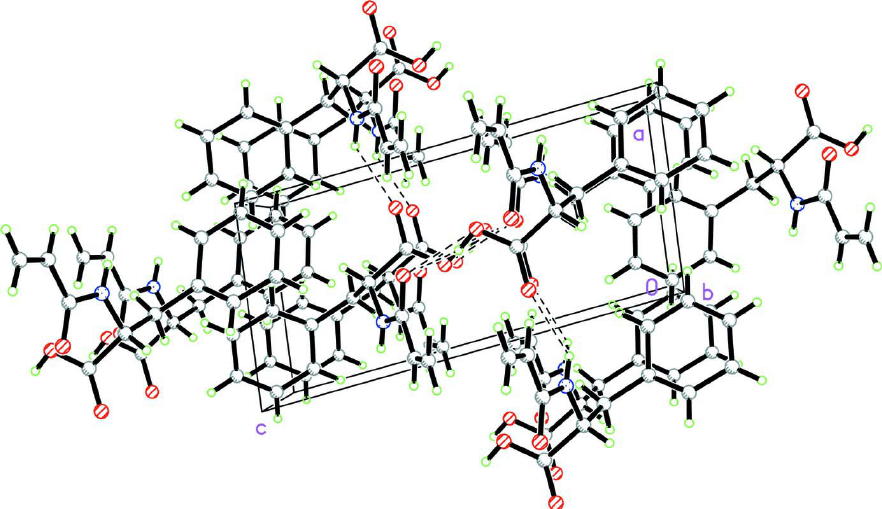
Figure 1 The molecular structure of the title molecule, with the atom-numbering scheme. Displacement ellipsoids are drawn at the 30% probability level.